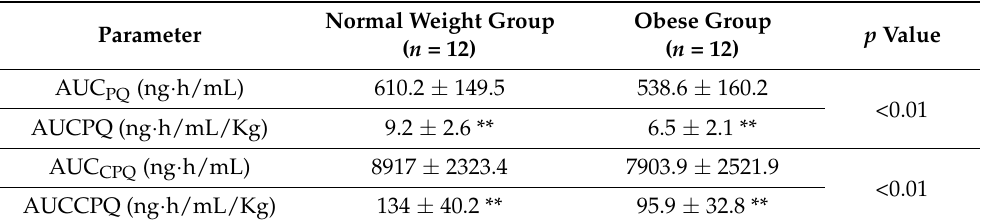
Table 3. Simulated * AUC of primaquine and carboxyprimaquine in the normal and obese groups after administration of a flat dose of primaquine 15 mg for 14 days.